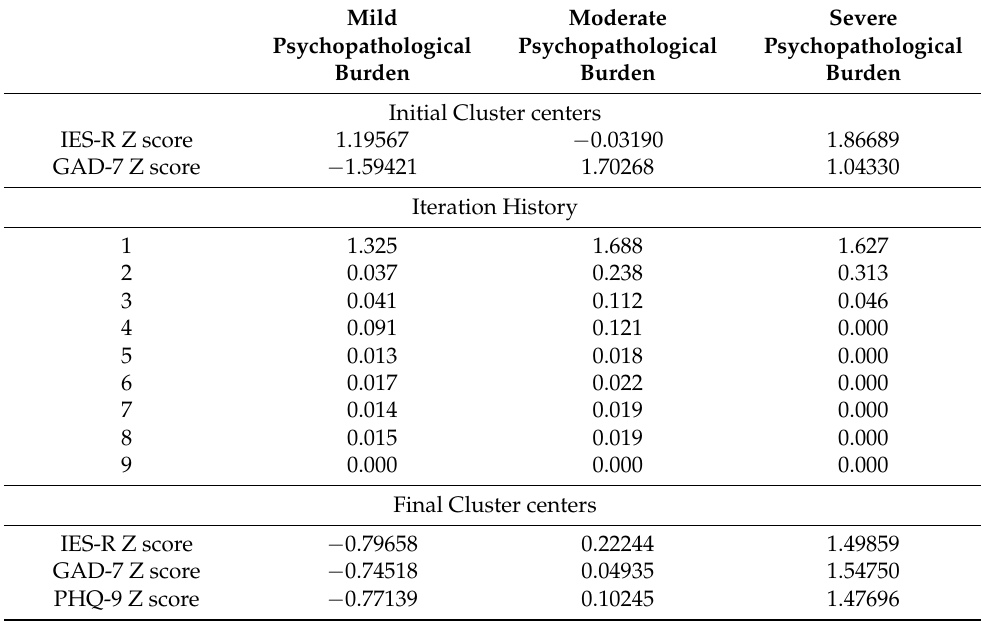
Table 1. K-Means Cluster Analysis features. Initial cluster centers, Iteration History and Final Cluster Centers in the Mild psychopathological burden ( n = 62), Moderate psychopathological burden ( n = 49) and Severe psychopathological burden ( n = 28)